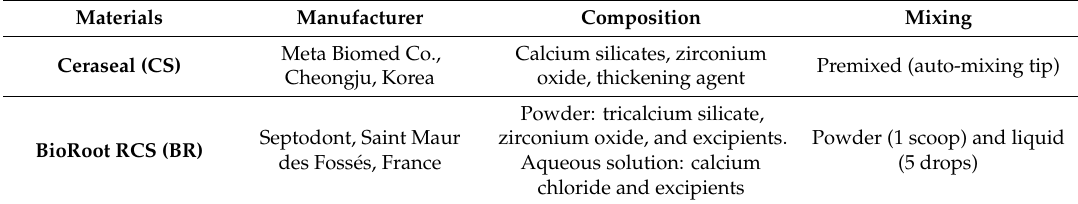
Table 1. Manufacturer, composition, and manipulation of the tested materials [13,18].